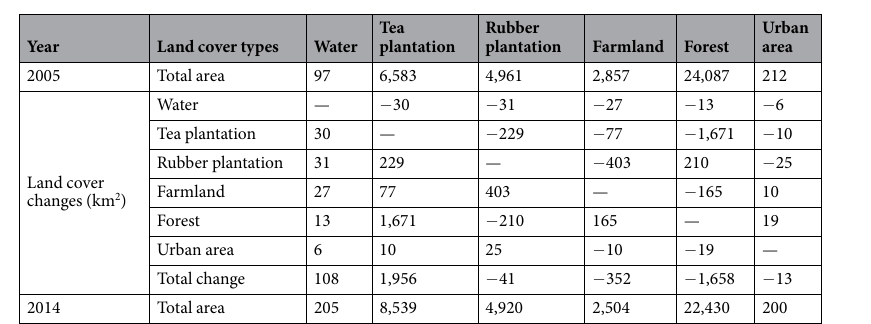
Table 2. Land use transfer matrix from 2005 to 2014 in the Asian elephant range area in China (km 2 ).